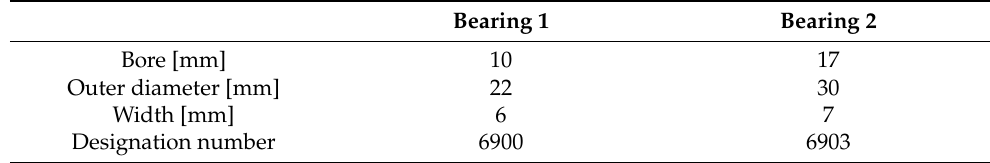
Table 3. Specifications of the bearings.